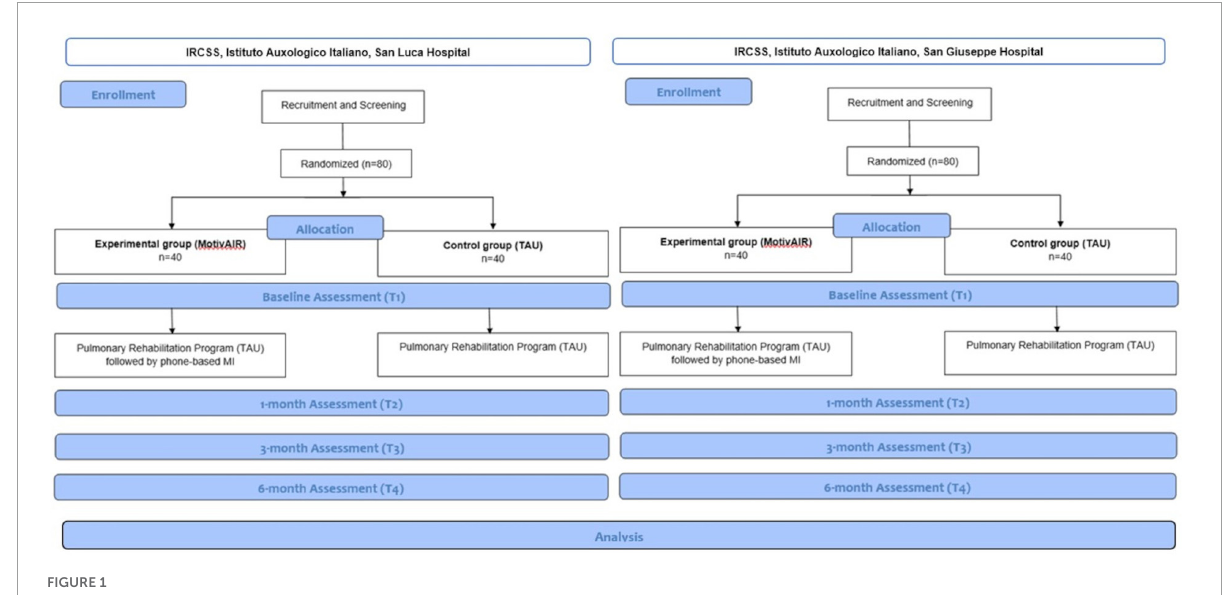
FIGURE1 Flow chart of the MotivAIR